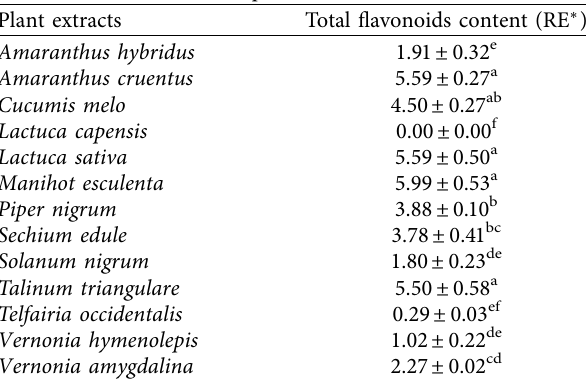
Table 4: Total flavonoid content of the methanol extracts of thirteen antibacterial edible plants. Plant